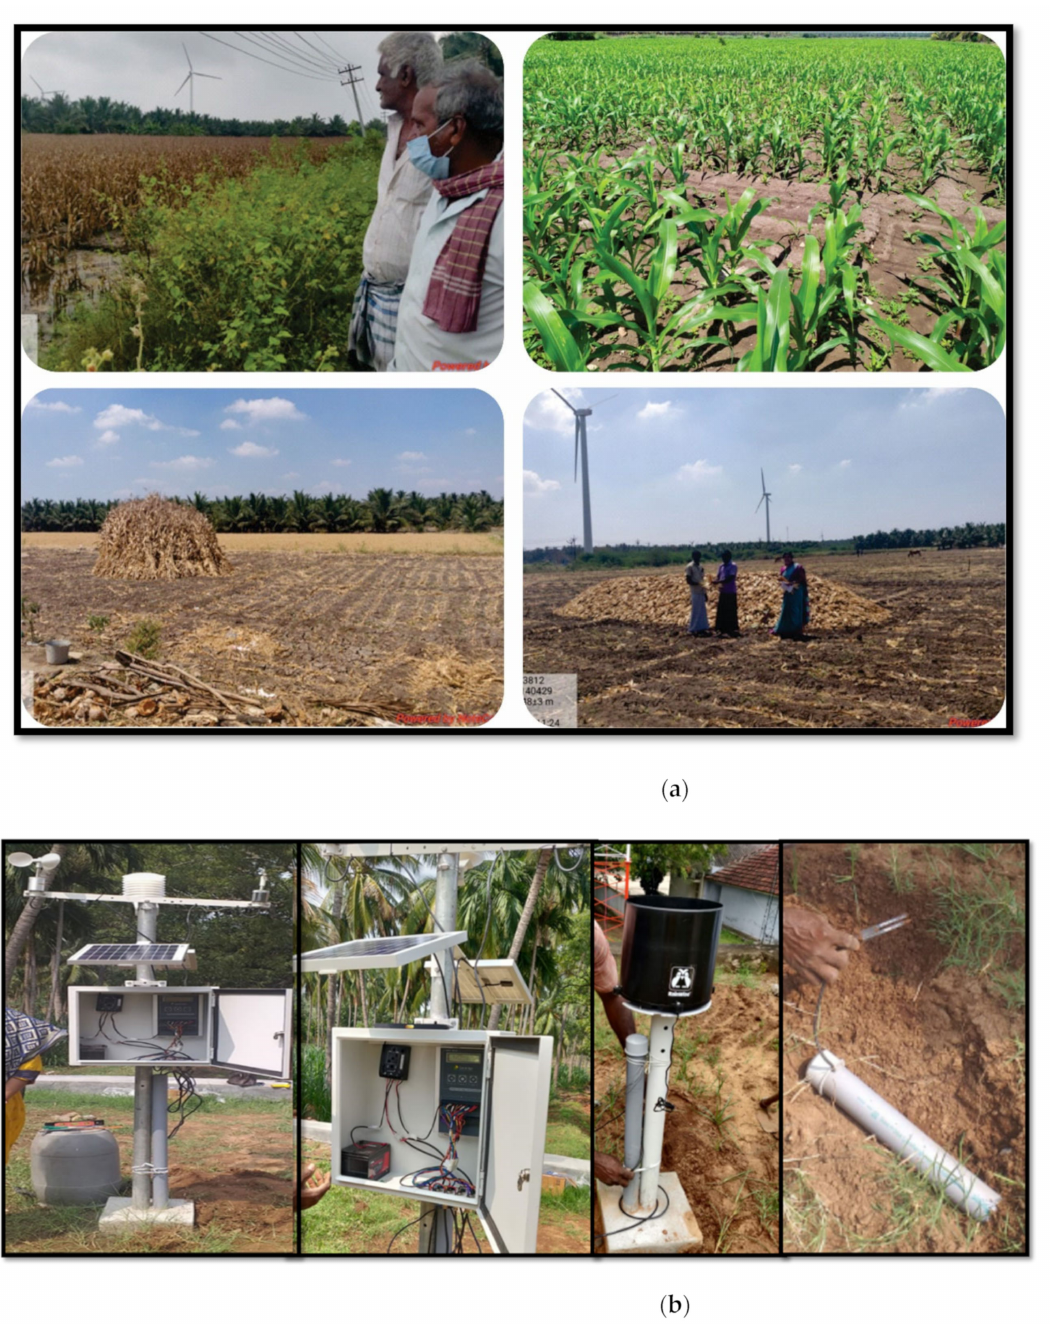
Figure 8. ( a ) Photos of the field survey with farmers ( b ). Field photos of the automatic weather station, rain gauge, and soil moisture